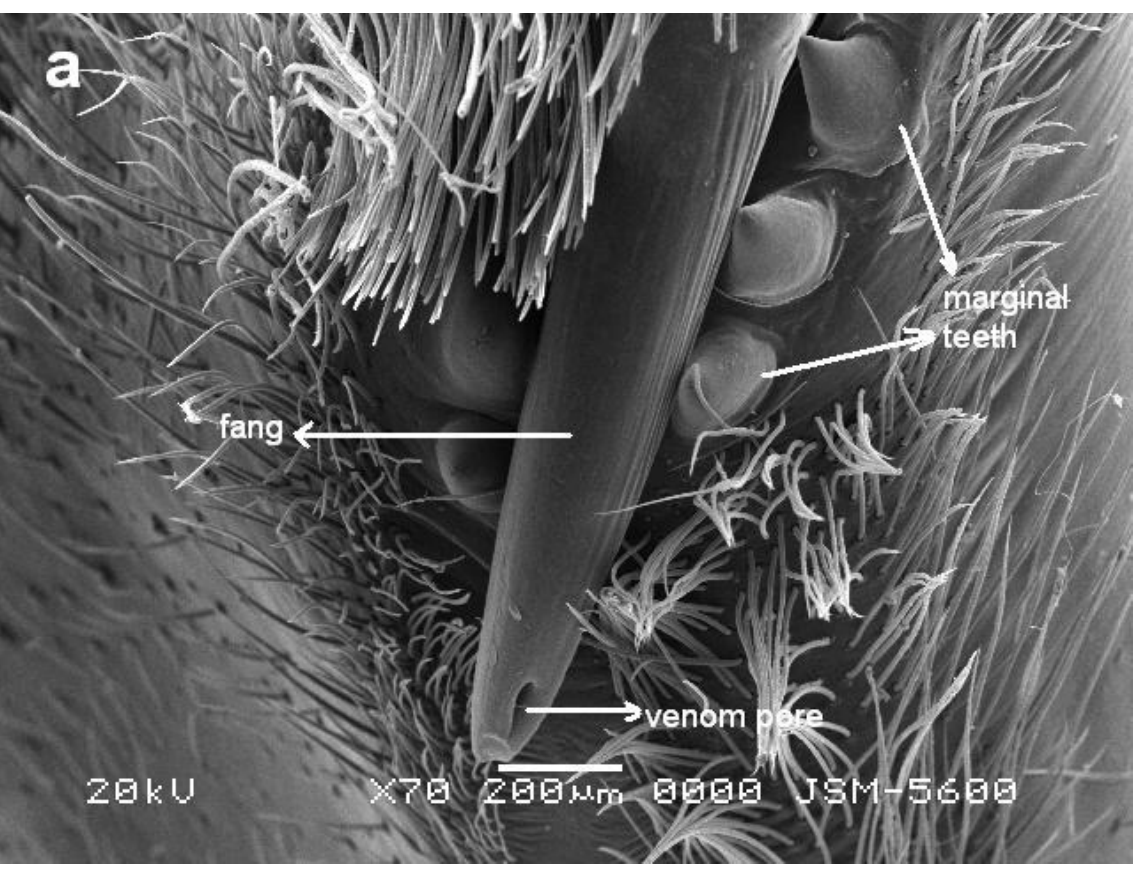
Figure 3. Detail of the